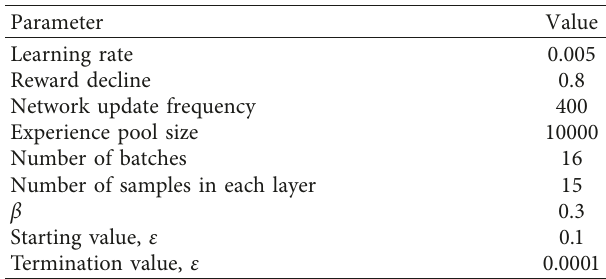
Table 1: Experimental parameters of robot path